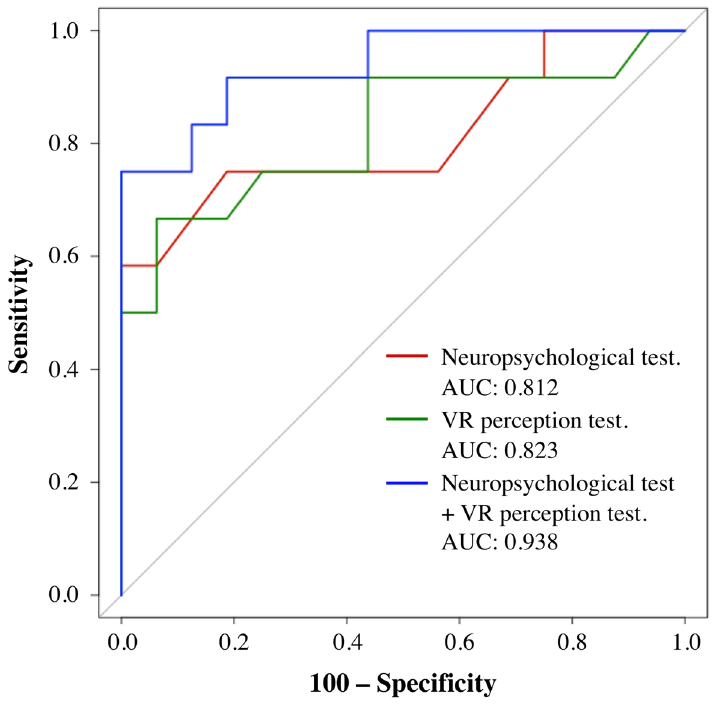
Figure 2. Comparison of receiver operating characteristic (ROC) curves. The area under the ROC curve (AUC) is shown. The best diagnostic performance was obtained by performing the neuropsychological test and the VR perception test concurrently. The neuropsychological test (TMT-A, with a cut-off value of 34.5) and the VR perception test (enlarged-body action-specific perception, with a cut-off value of − 0.7 cm) distinguished between the patients with MCI and the other groups with 75.0% sensitivity and 100.0%